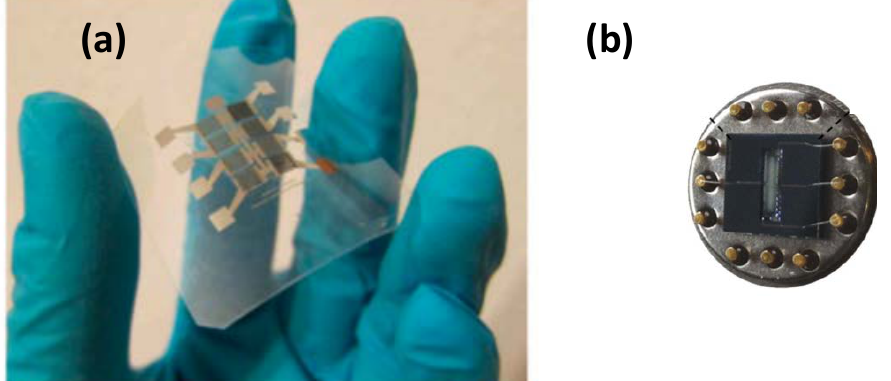
Figure 4. ( a ) Flexible gas sensor, “Reprinted/adapted with permission from Ref. [40]. 2014, Lor- wongtragool, P.” and ( b ) micromachined gas sensor, “Reprinted/adapted with permission from Ref. [41]. 2014, Stoycheva, T. et al.”.